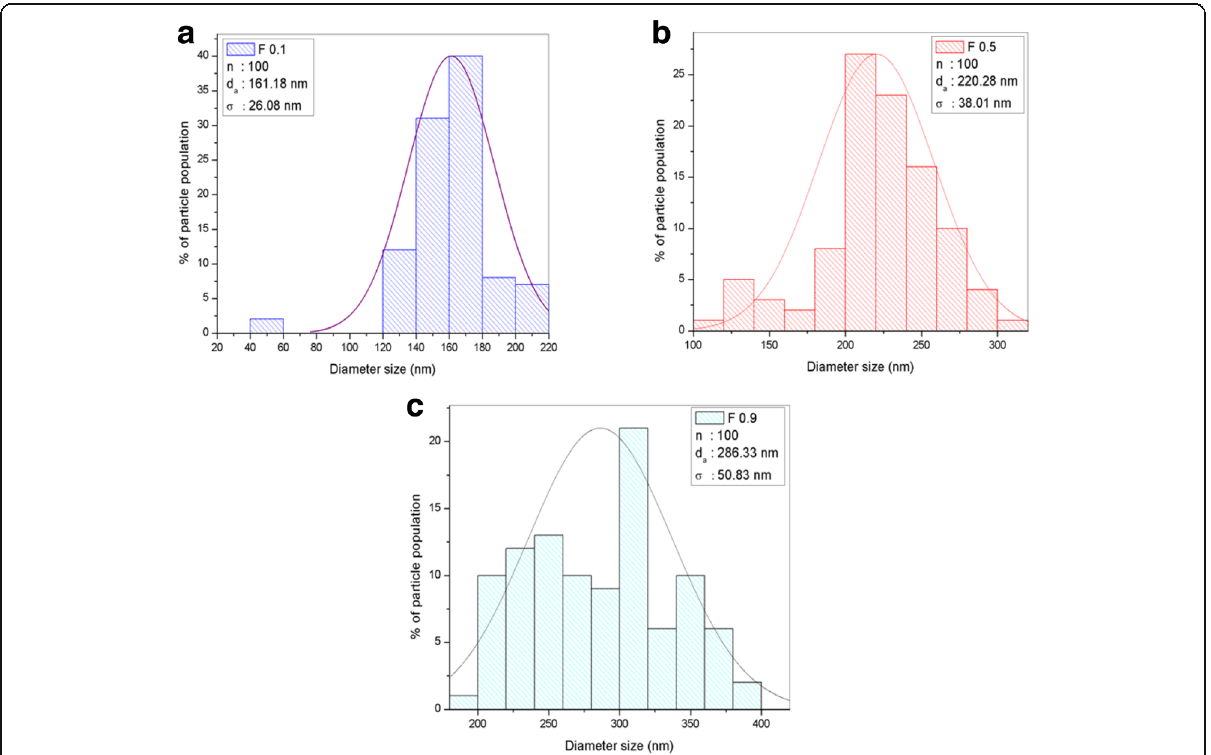
Fig. 5 Histogram data of diameter size distribution with the parameter of n, d a , and σ . a TiO 2 -CNF (F0.1). b TiO 2 -CNF (F0.5). c TiO 2 -CNF